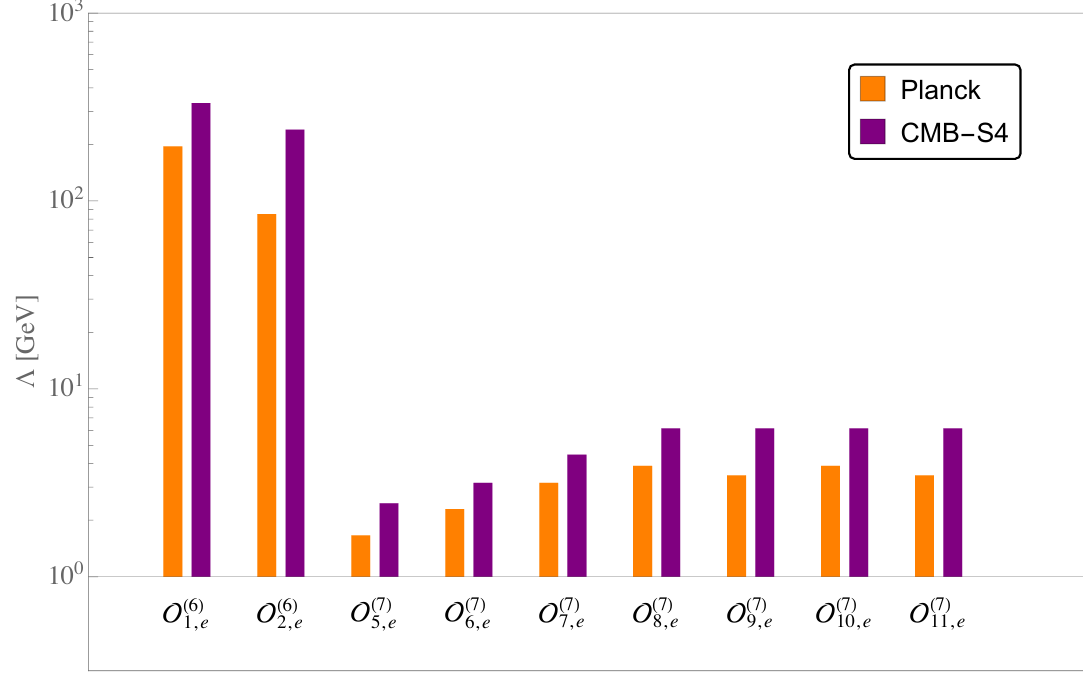
, − N SM eff eff , and N SM+EFT is that from SM and new eff eff